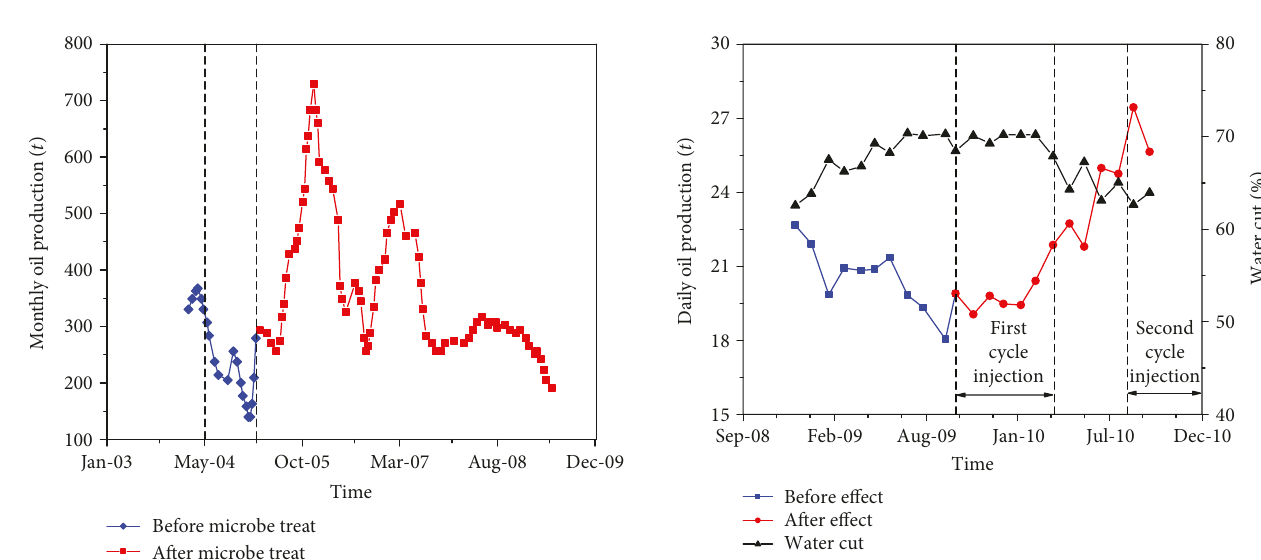
Figure 10: Chao 50 MFR fi eld test well pattern in Daqing Oil fi eld [54].